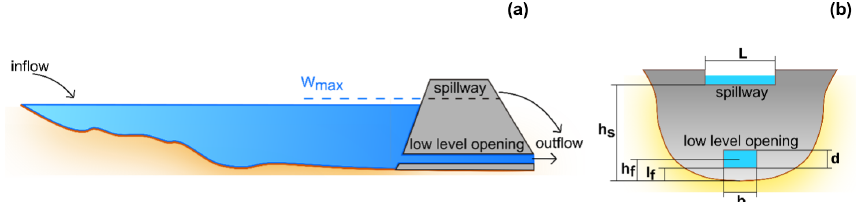
Figure 1. Sketch of a detention basin section with a basin capacity W max , composed of a low-level opening, with an area equal to the product between b and d , and a crest spillway of length L and height h s .